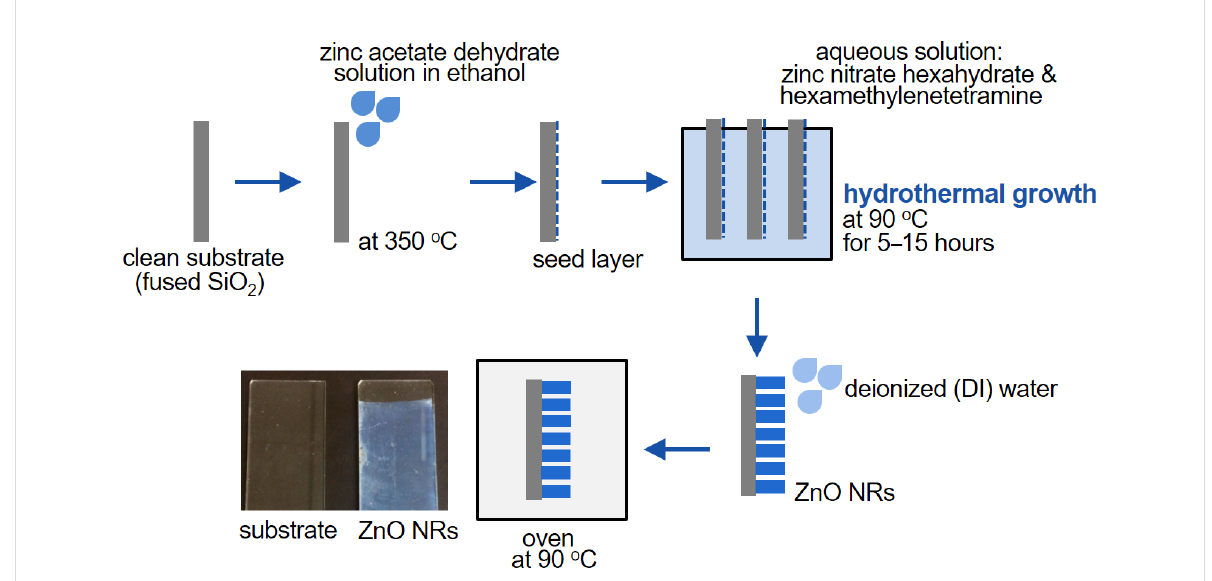
Figure 7: Schematic of the fabrication process of the ZnO NR saturable absorbers.